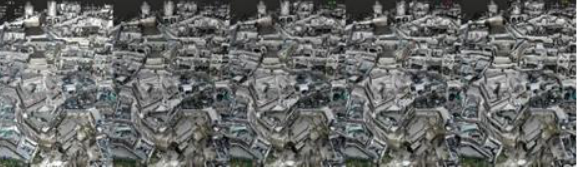
Figure 18. Results in VR. Top : Detailed visualization of Oia village; bottom : Sentinel 2 imagery combined with DTM